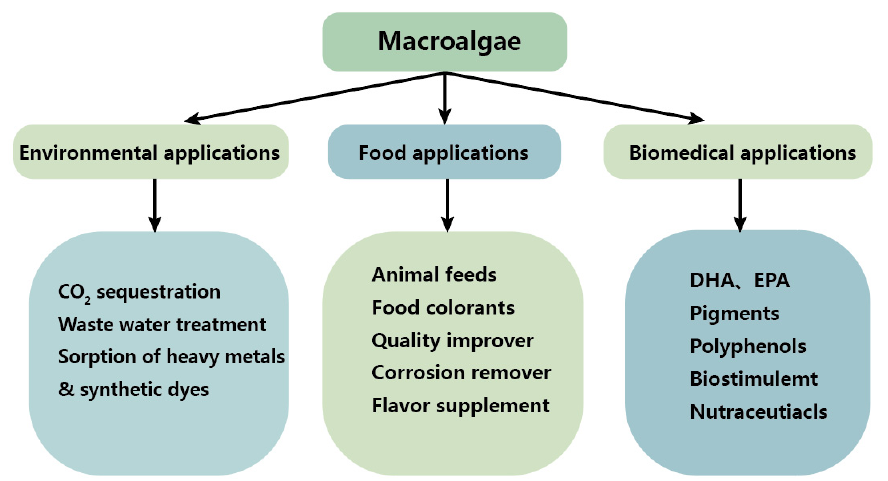
Figure 1. Comprehensive application of macroalgae.